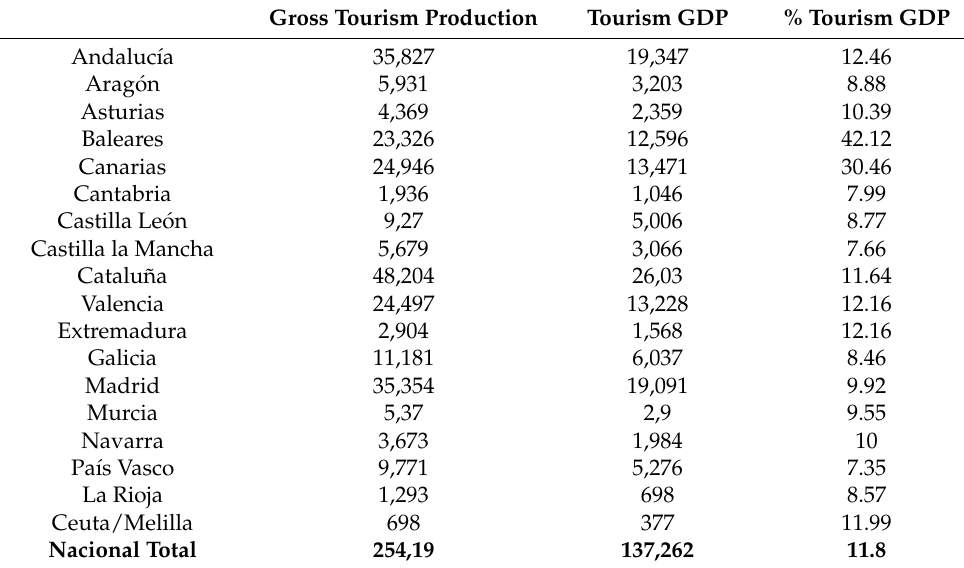
Table 1. Tourism as a share of GDP, 2019. Millions of